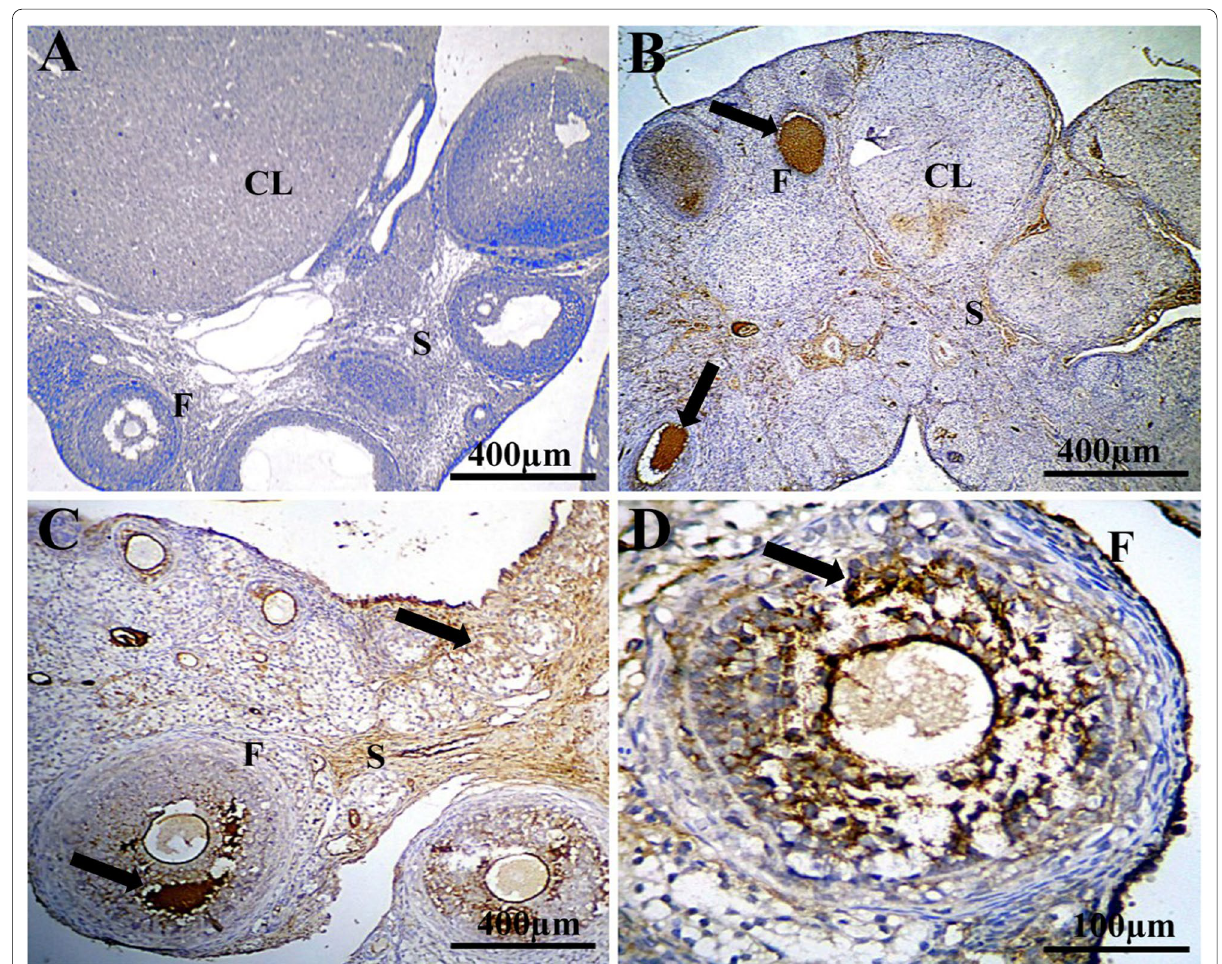
Fig. 5 Immunohistochemistry comparing caspase‑3 staining in ovarian tissue ( n stain caspase‑3 was observed. Magnetite‑treated groups ( B – D ): positive expressions of immune stain caspase‑3 were observed (black arrows). Many follicles (F) in various stages of development, corpus luteal (CL), and stroma